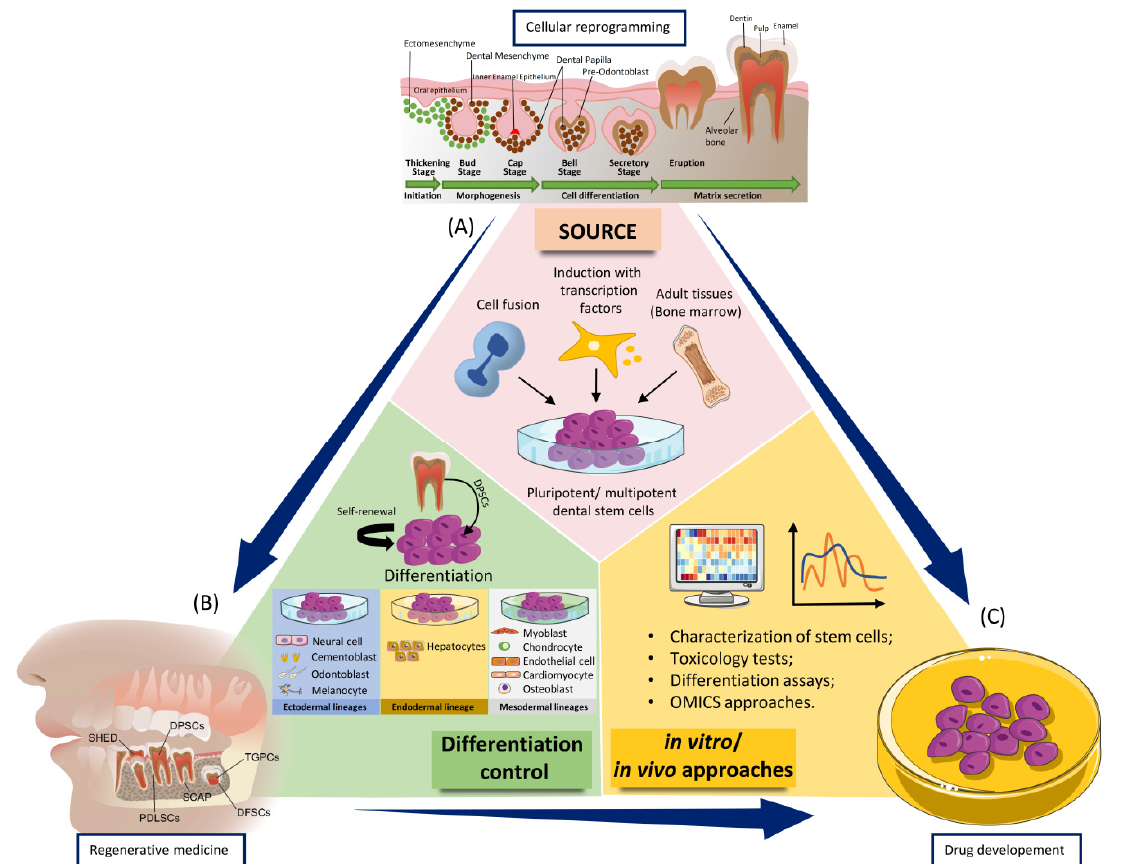
Figure 2. The main applications of the dental stem cells in regenerative medicine, differentiation control, drug design, and testing in dental field. Most applications required three basic steps: ( A ) obtaining pluripotent/multipotent dental stem cells from sources such as cell fusion, induction with transcription factors (Oct3/4, Sox2, c-Myc, Klf4, Oct4, Sox2, Nanog, and Lin28) and from adult tissues such as bone marrow. Pluripotent/multipotent dental stem cells can be used in differentiation as well as in subsequent in vitro/in vivo approaches; ( B ) Dental pulp stem cells (DPSCs) have the ability to self-renewal and differentiation into different cell types of the three germ layers: endoderm, mesoderm, and ectoderm. After the differentiation process, the cells can be used in various in vitro/in vivo approaches; ( C ) in vitro/in vivo approaches to dental stem cells to determine their different functions.